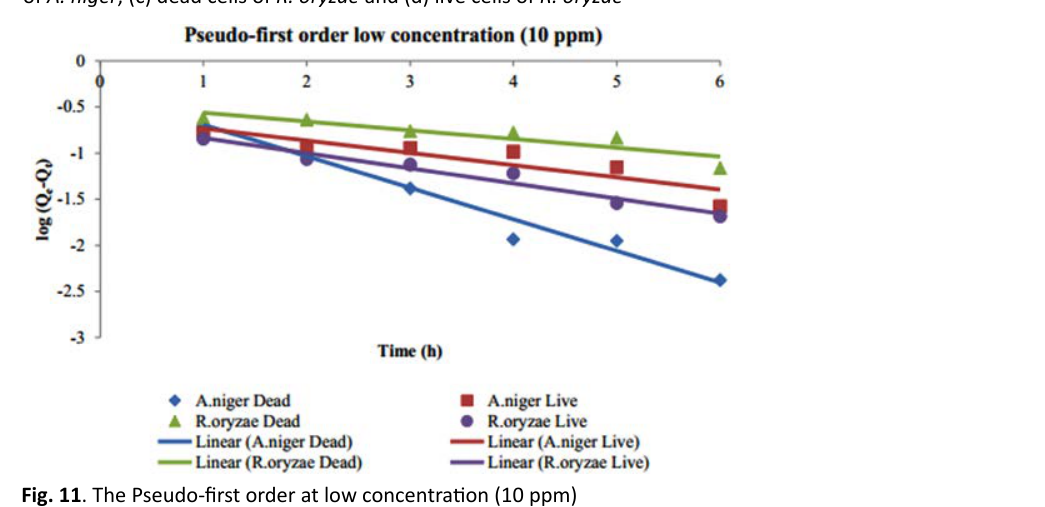
Fig. 10 . Kinetics of biosorption of Hg 2+ at high concentration (100 ppm) by (a) dead cells of A. niger , (b) live cells of A. niger , (c) dead cells of R. oryzae and (d) live cells of R.